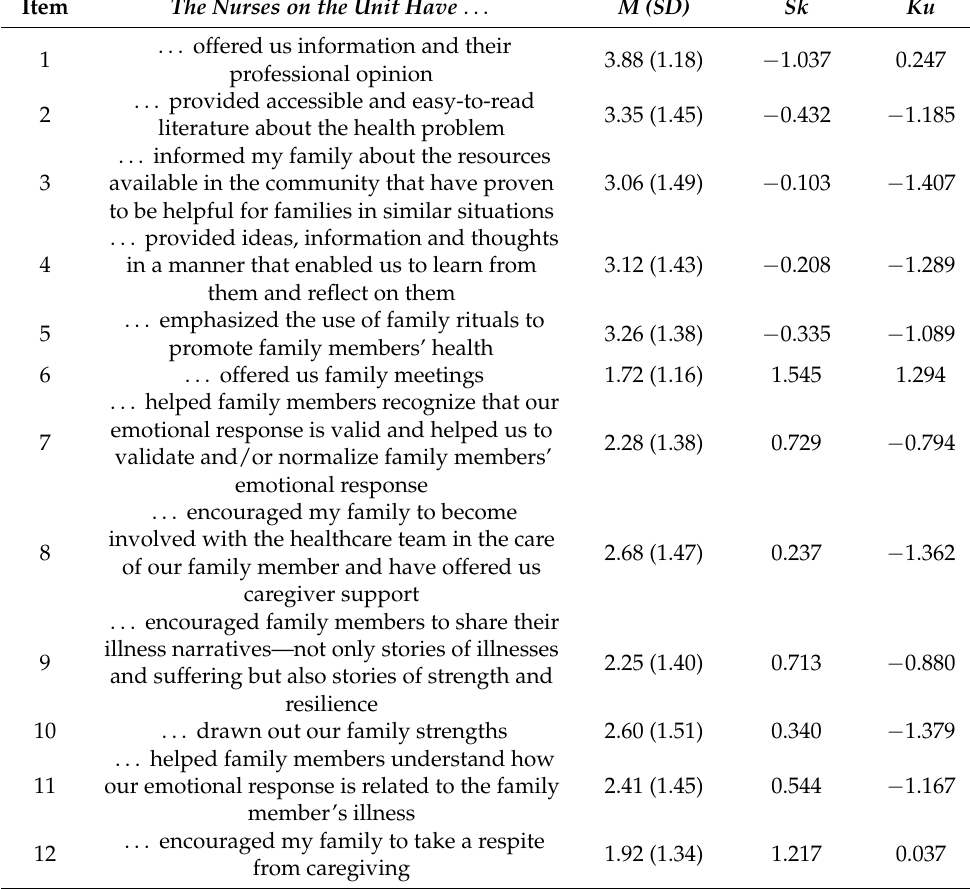
Table 3. Descriptive statistics of the items of the Portuguese version of ICE-FPSQ ( n = 237).